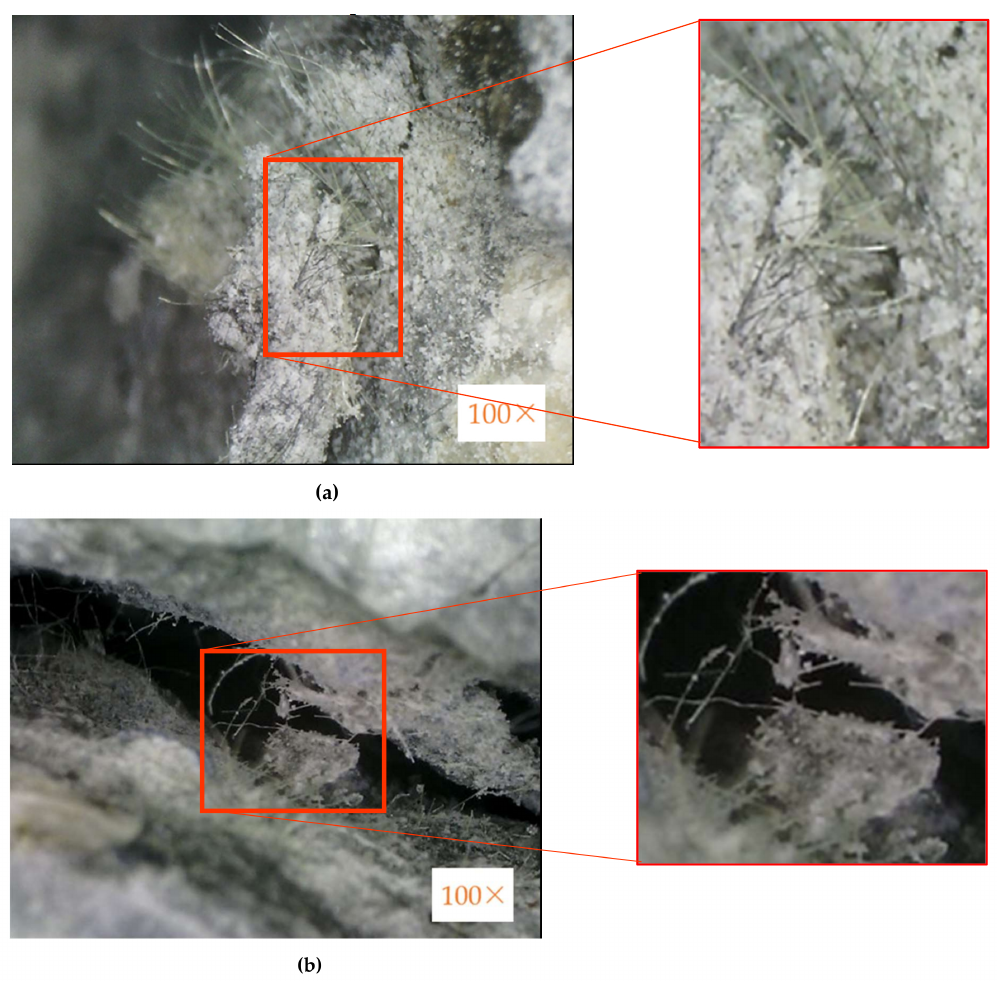
Figure 13. Optical microscopic image of I-K5/C5 specimen’s failure mode under impact loading: ( a ) fracture, ( b )